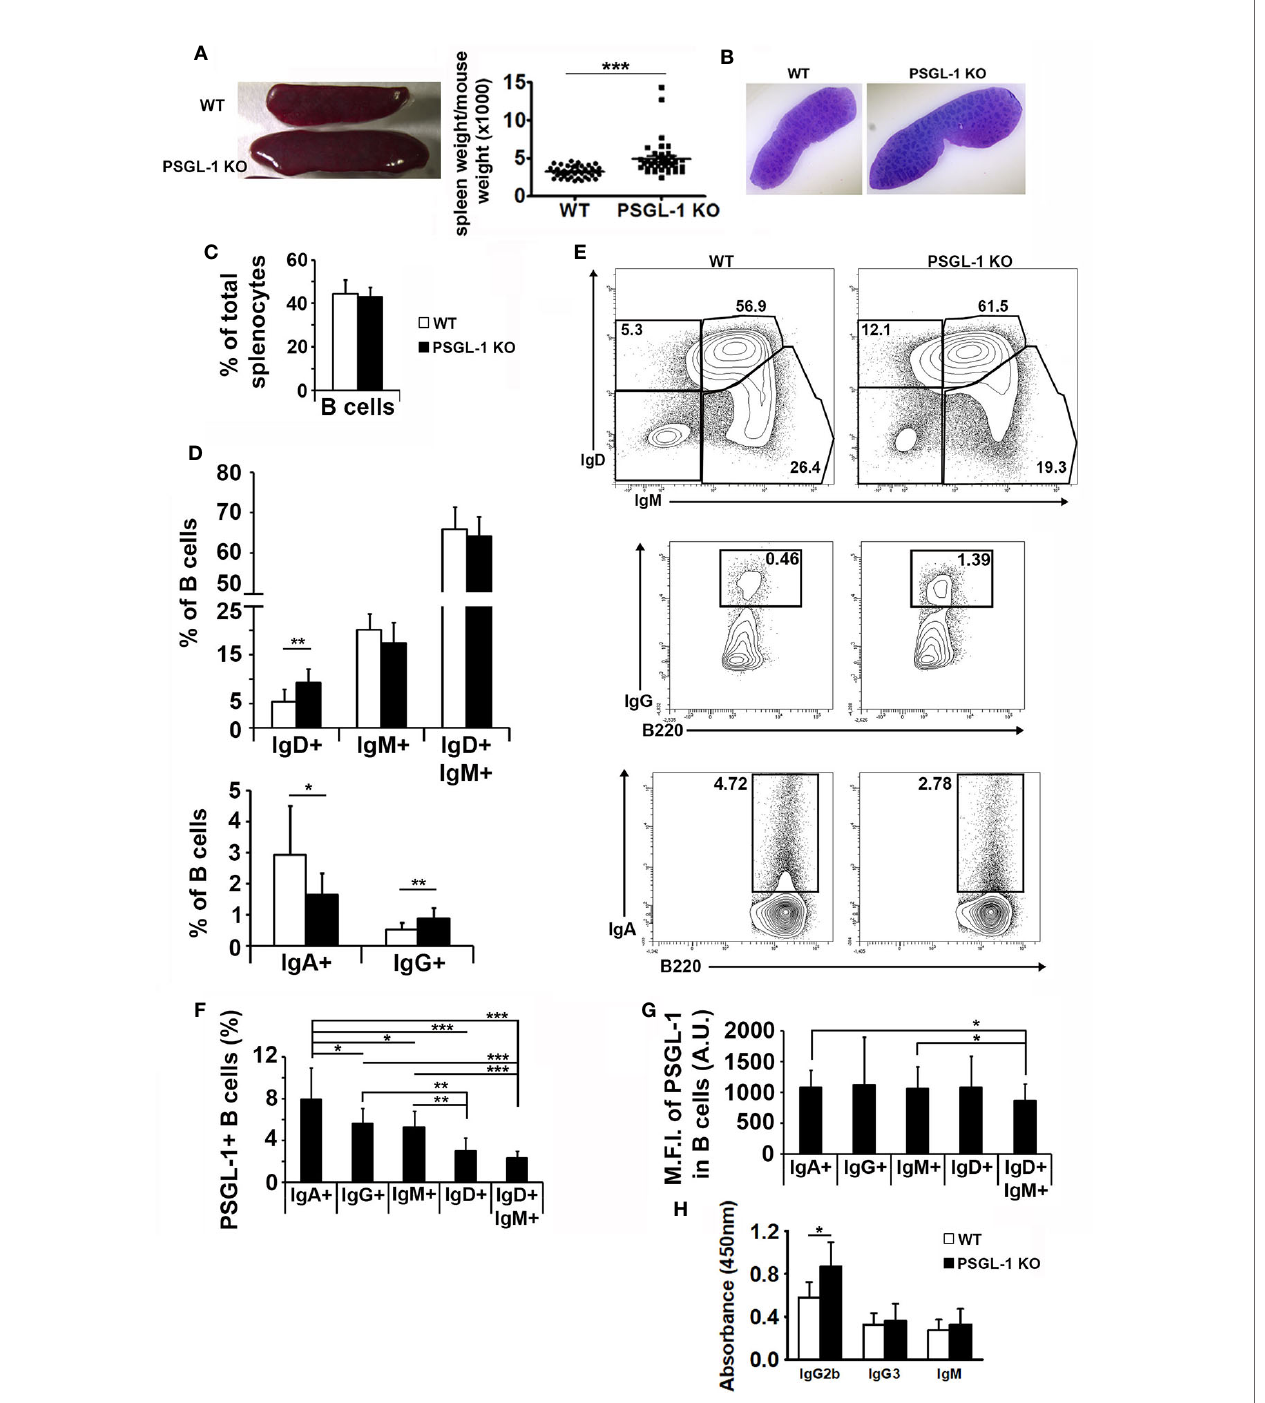
FIGURE 4 | PSGL-1 could modulate immunoglobulin expression on B cells. (A) Left panel: image showing the spleens of 3-month-old WT (above) and PSGL-1 − / −